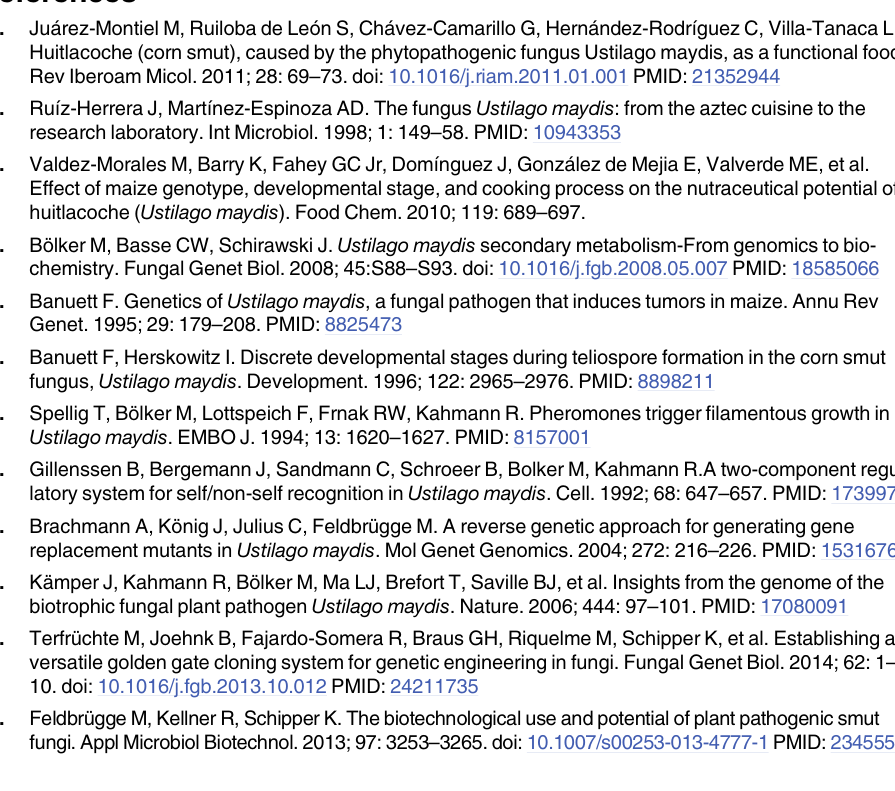
S1 Table. Yield of ‘ huitlacoche ’ produced after inoculation of corn cobs with the U .